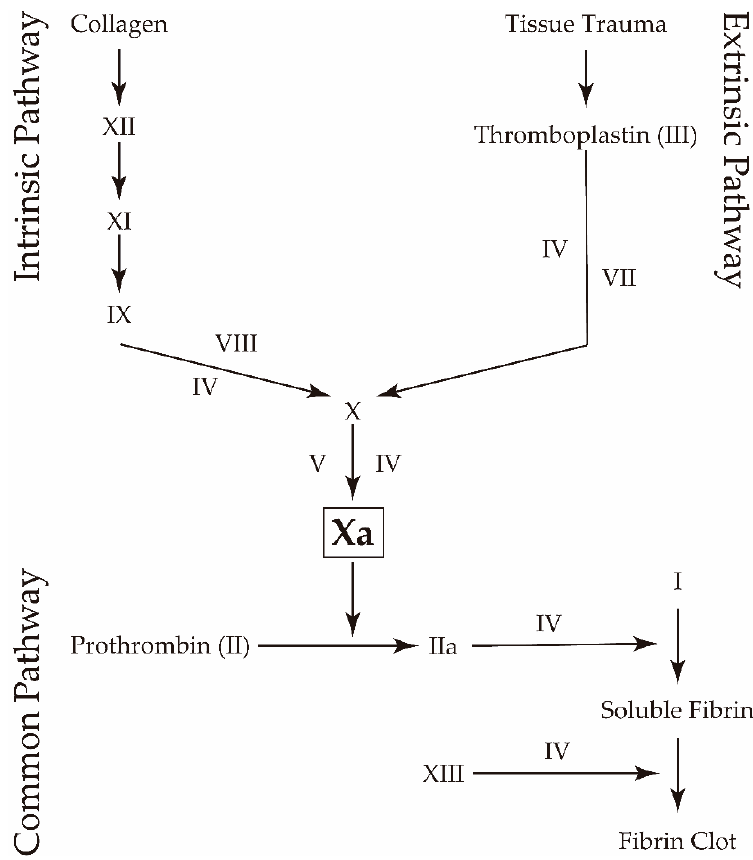
Figure 1. Blood coagulation cascade: extrinsic, intrinsic, and common pathway.